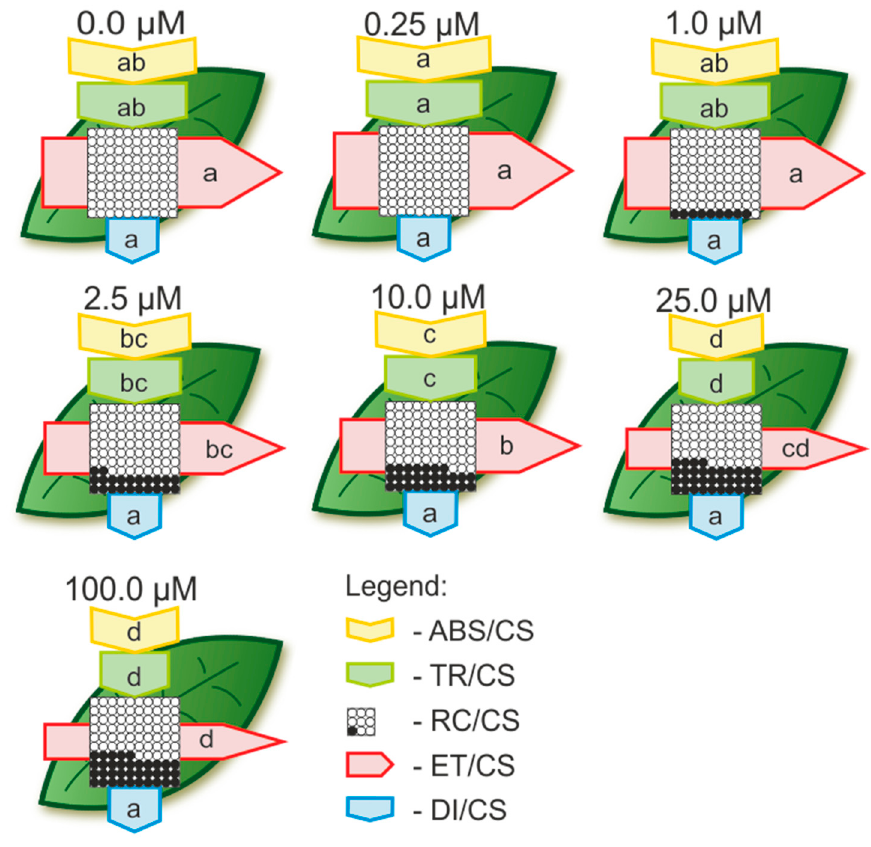
Figure 4. Leaf models showing the phenomenological energy fluxes per the excited cross sections (CS) of corn leaves treated with different Cd concentrations. Each relative value is the mean ( n = 15) and is represented by the size of the correct parameters (arrows). Letters in the arrows correspond to the statistical significance (LSD test, p < 0.05). ABS/CS—absorption flux per CS approximated; TR/CS—trapped energy flux per CS; ET/CS—electron transport flux per CS; RC/CS—% of active/inactive reaction centers as circles inscribed in the square (white = active, black = inactive); DI/CS—dissipated energy flux per CS.